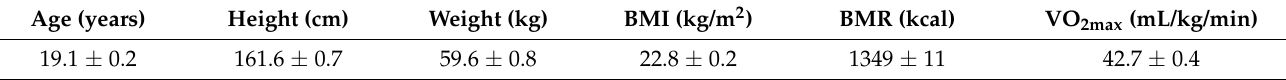
Table 1. Recruit Demographics, n = 79.